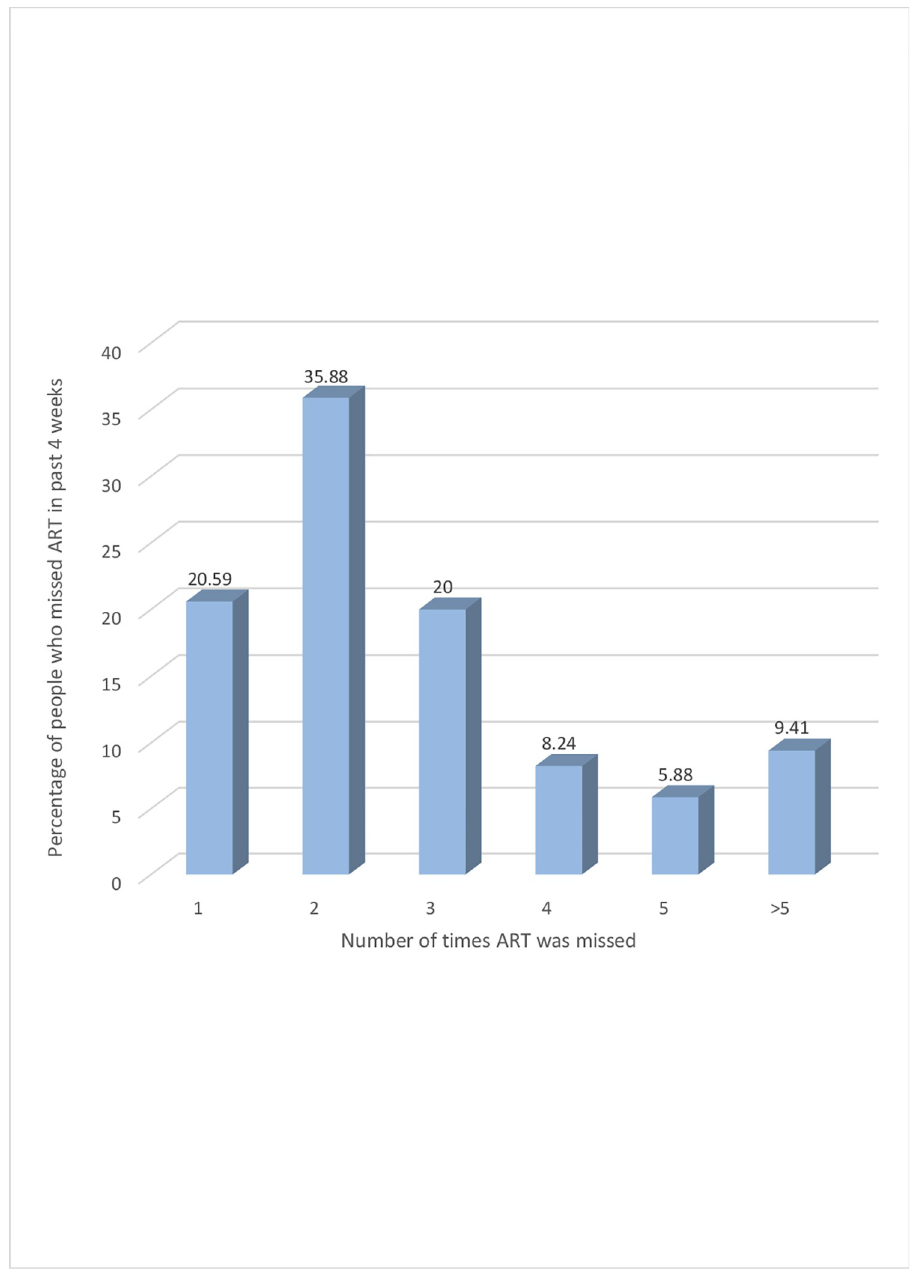
Fig 1. Proportion of patients who missed ART in past 4 weeks versus number of times ART was